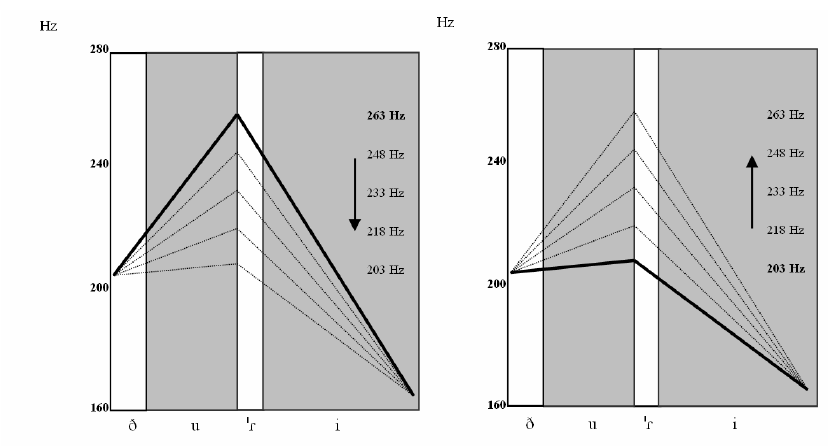
Figure 3. Schematized creation of the stimuli from yes-no question base stimulus (left panel) and what-question base stimulus (right